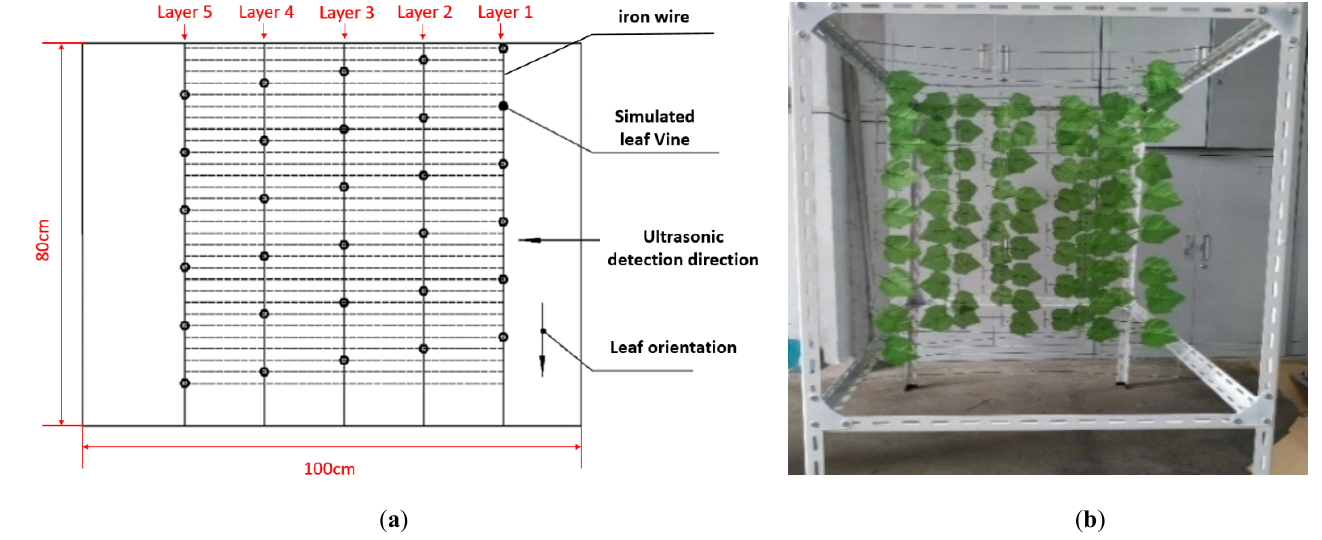
Figure 2. ( a ) Top view schematic of test rig; ( b ) simulated canopy test rig.